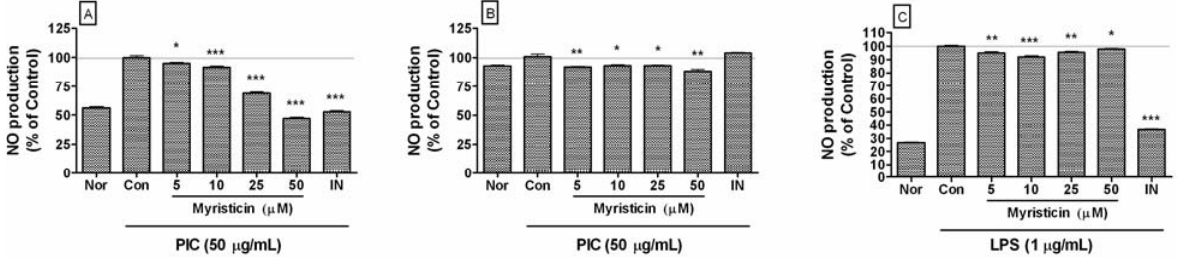
Figure 3. Effects of myristicin on NO production in dsRNA-stimulated RAW 264.7 mouse macrophages and THP-1 human monocytes. NO production was measured after 24 h treatment in RAW 264.7 (A, C) and THP-1 (B) by the Griess reaction assay. Normal group (Nor) was treated with media only. Control group (Con) was treated with the synthetic analog of dsRNA (PIC, 50 µg/mL of polyinosinic-polycytidylic acid) or lipopolysaccharide (LPS, 1 µg/mL) alone. IN denotes indomethacin (0.5 µM). Values are the mean ± SEM of three independent